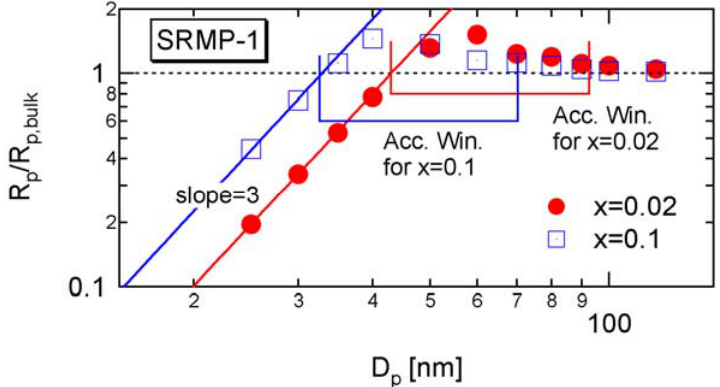
Figure 6. Calculated polymerization rate at 2 and 10% conversion for the miniemulsion polymerization of SRMP-1 with various particle diameter, D acceleration window, (cid:1830) (cid:2926),T(cid:2928)(cid:2911)(cid:2926)(cid:4666)(cid:2869)(cid:4667) is calculated from Equation (13), and the upper limit, (cid:1830) (cid:2926),T(cid:2928)(cid:2911)(cid:2926)(cid:4666)(cid:2929)(cid:2932)(cid:4667) is from Equation (18) shown in Section